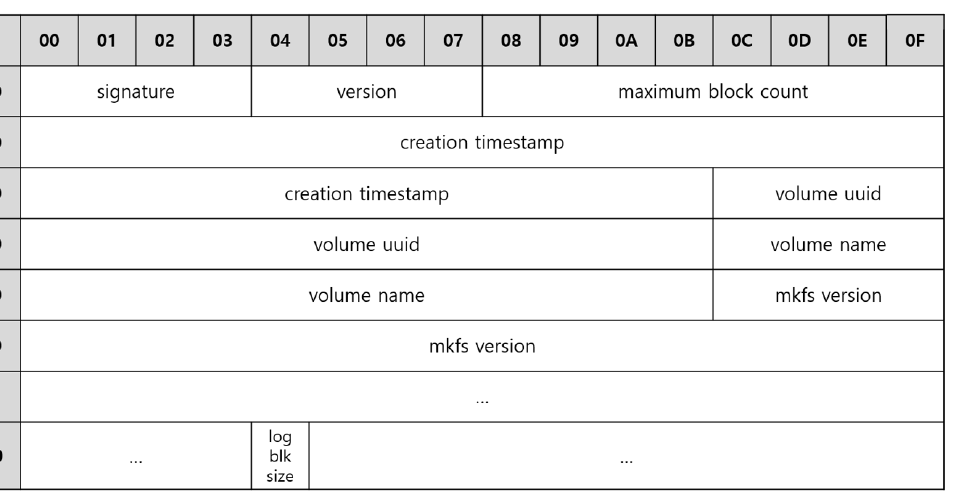
Figure 5. VDFS superblock structure in form of hex value.